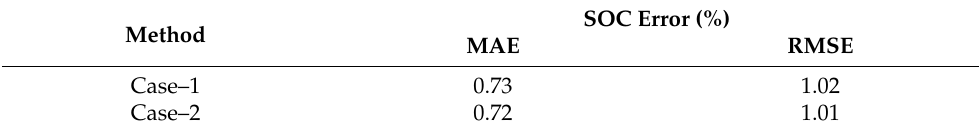
Table 10. SOC error (%) of two cases under the FUDS test.